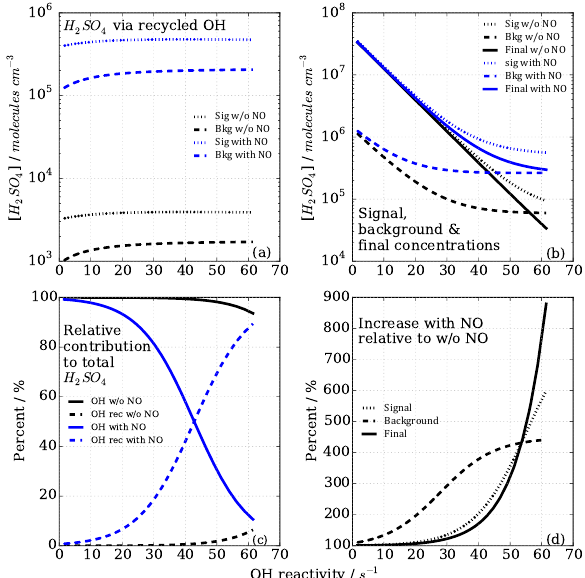
Figure 7. Modelled CIMS H 2 SO 4 concentrations and contributions from OH recycling in titration zone 2 with and without NO im- purity (140ppt) present. (a) Absolute H 2 SO 4 concentrations from recycled OH only in signal and background measurement mode. (b) Total H 2 SO 4 concentrations. (c) Relative contribution from OH UV and OH recycled to the total (and final) H 2 SO 4 concentra- tion. (d) Non-linear increases in signal, background and final mea- surements in case of presence of NO